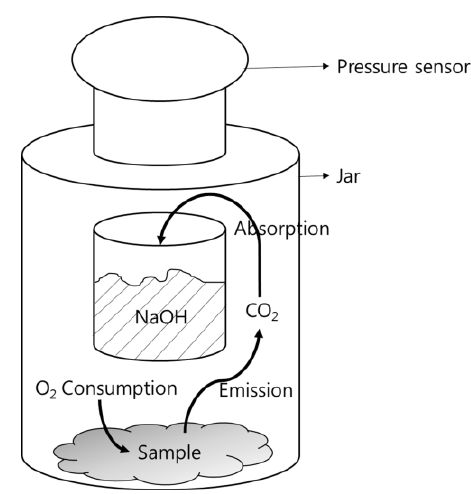
Figure 1. Schematic diagram of pressure measurement